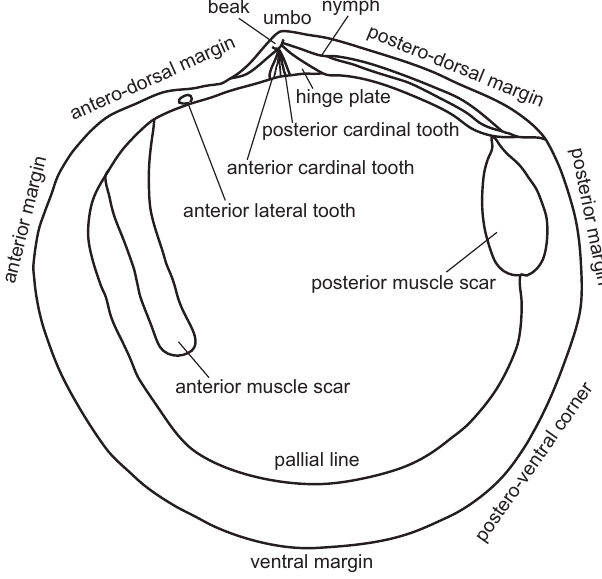
Fig. 2. Schematic drawing of a model lucinid bivalve with explanation of the main morphological terms used in this paper.